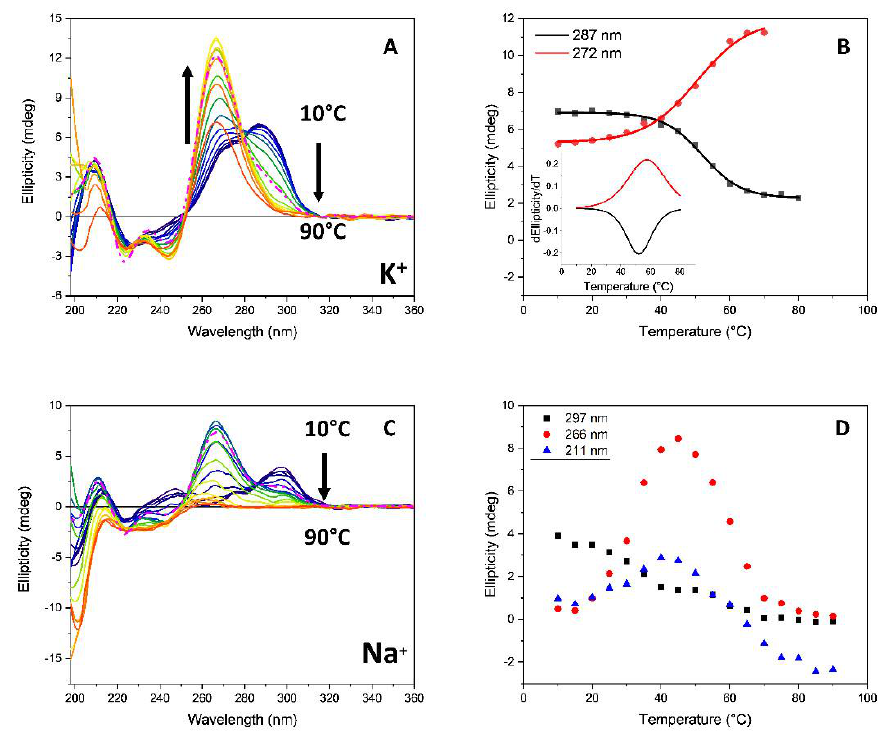
Figure 10. Thermal annealing of SRCD spectra of Htelo1 (13.5 µ M) with 2.2 eq. of Rhau25 peptide in 10 mM Tris-HCl buffer, pH 7.4, containing 70 mM potassium ions ( A ) or sodium ions ( C ) from 10 ◦ C to 90 ◦ C every 5 ◦ C. The dashed line represents the oligonucleotide cooled to 20 ◦ C after heating to 90 ◦ C. The arrows represent the direction of the signal change as the temperature is increased. ( B ) Plots of SRCD intensity versus temperature in K + buffer at 272 nm (red) and 287 nm (black) with insert of the corresponding first derivatives. ( D ) Plots of SRCD versus temperature in Na + buffer at 211 nm (blue), 266 nm (red), and 297 nm (black).